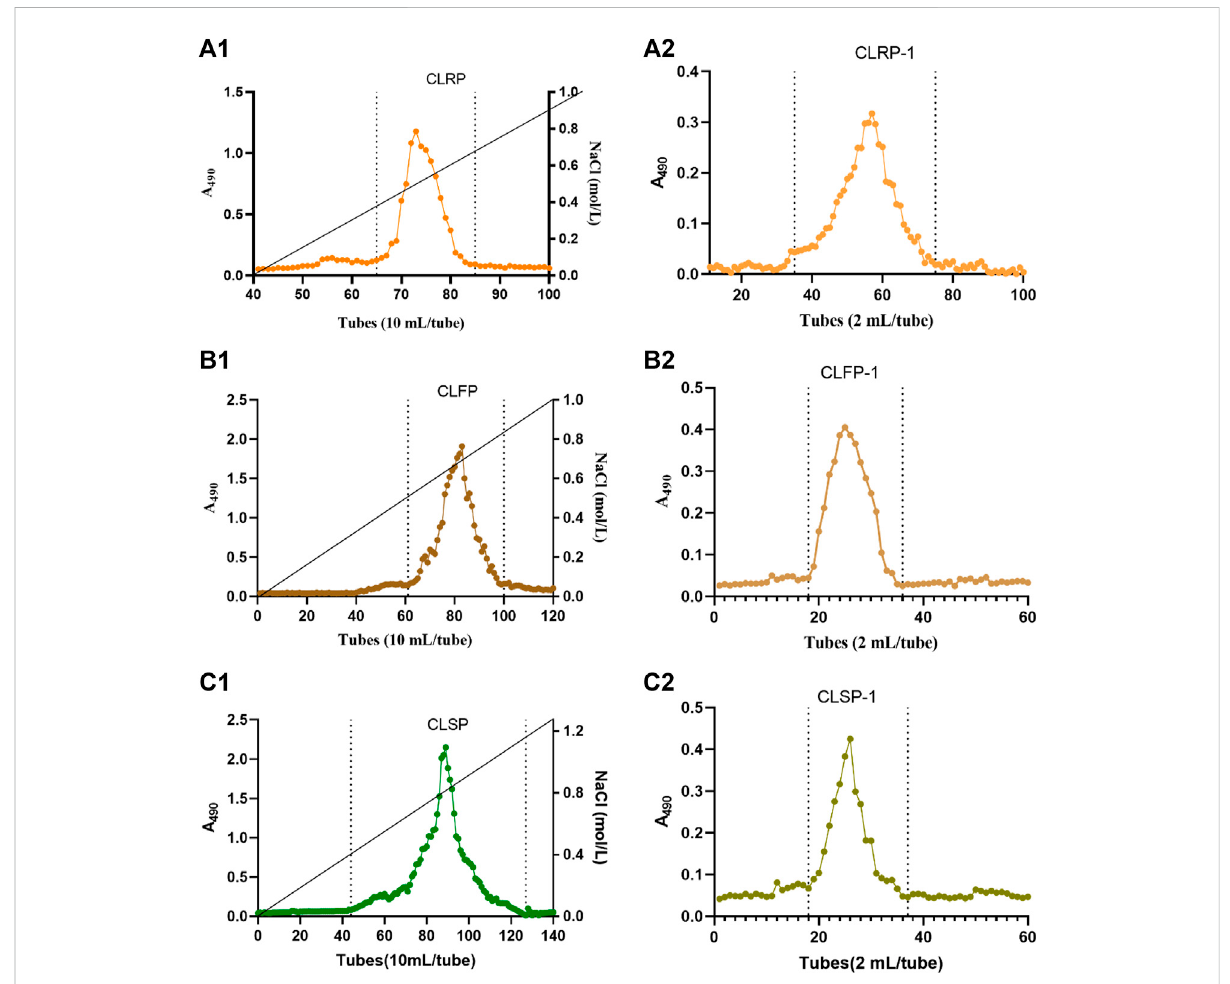
FIGURE 2 The elution pro fi les of CLRP, CLFP and CLSP. Elution curves of CLRP-1, CLFP-1 and CLSP-1 on DEAE anion exchange chromatography (A1,B1,C1) and puri fi cation of polysaccharide fractions of CLRP-1, CLFP-1 and CLSP-1 by gel fi ltration (A2,B2,C2) , respectively. A 490 represents the absorbance at 490 nm by phenol-sulphuric acid